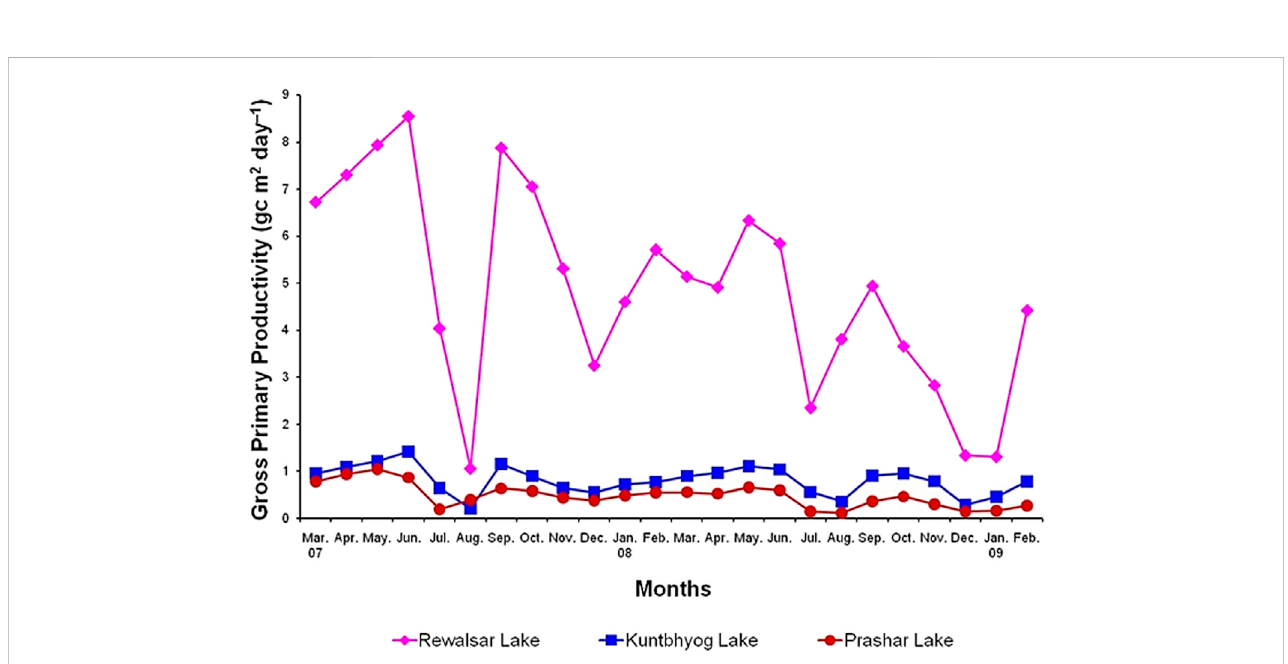
FIGURE 3 Monthly fl uctuations in primary productivity in different